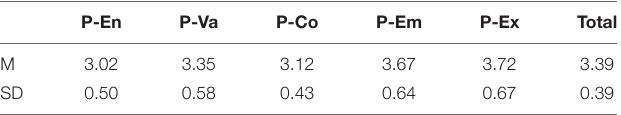
TABLE 1 | Analysis of 635 medical students’ professional